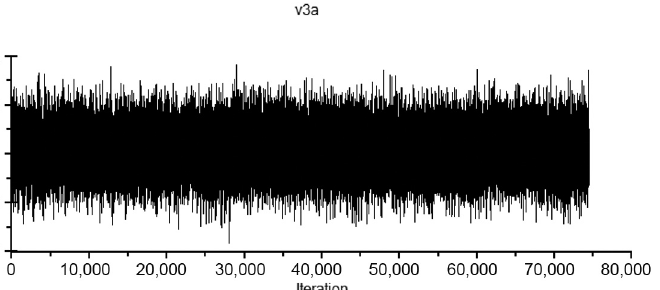
Figure 6 Bayesian SEM diagnostic histogram plot for VOLDIFF